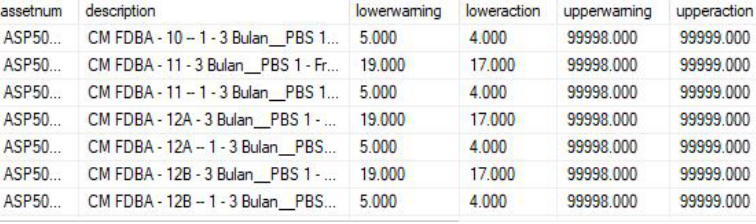
Fig. 5. Duplicate data on data